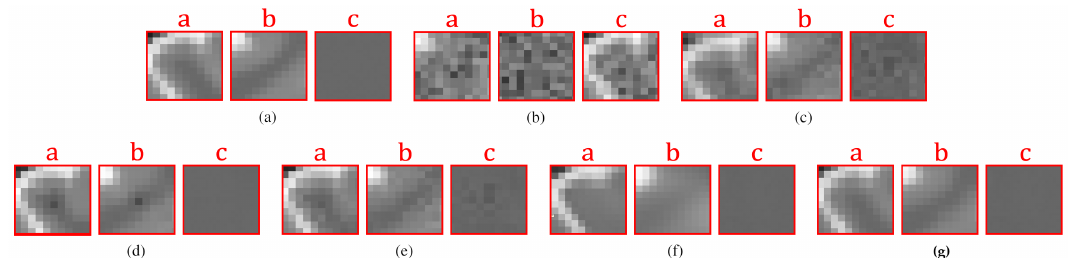
Figure 13. Zoom-in on the details labeled as “a”, “b”, and “c” in Figure 12. Figures ( a – g ) correspond to the zoom-in of the Original image, the Noisy image, the KSVD, the PRINLM, the BM4D, the DnCNN, and the NLSD, respectively.